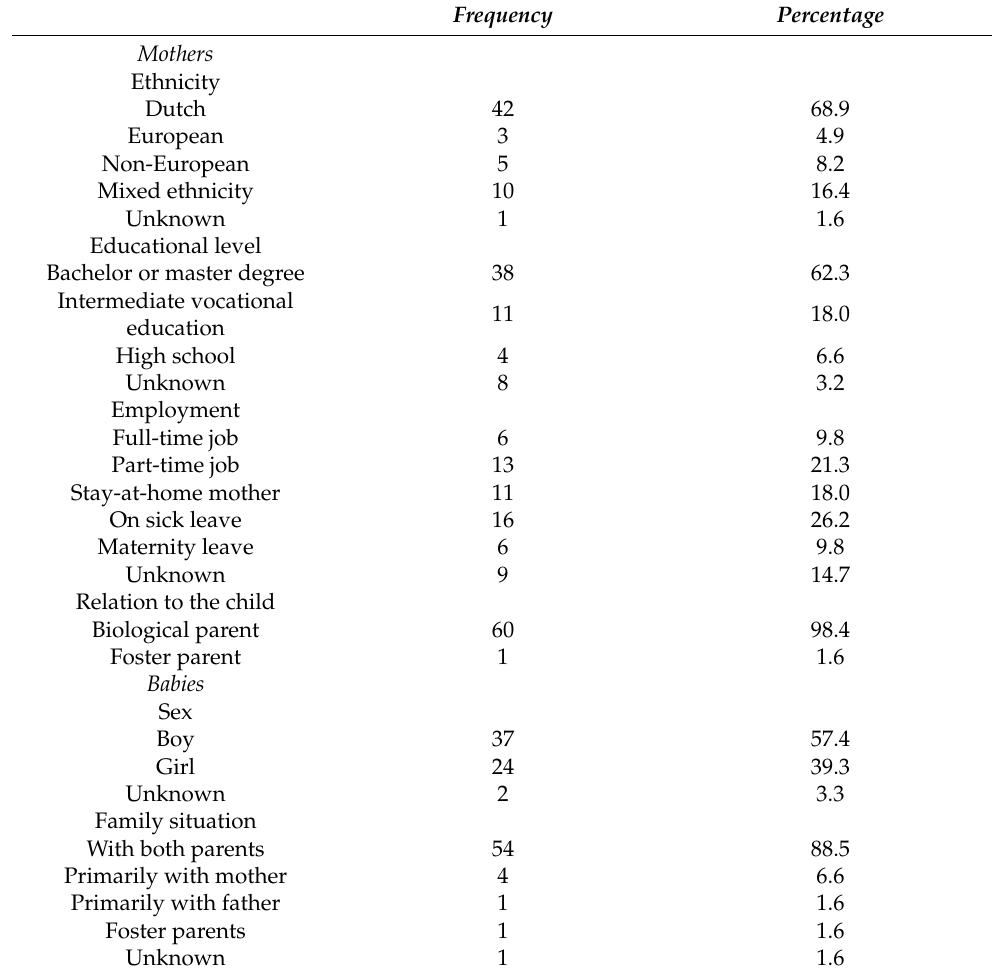
Table 2. Sociodemographic characteristic of the study